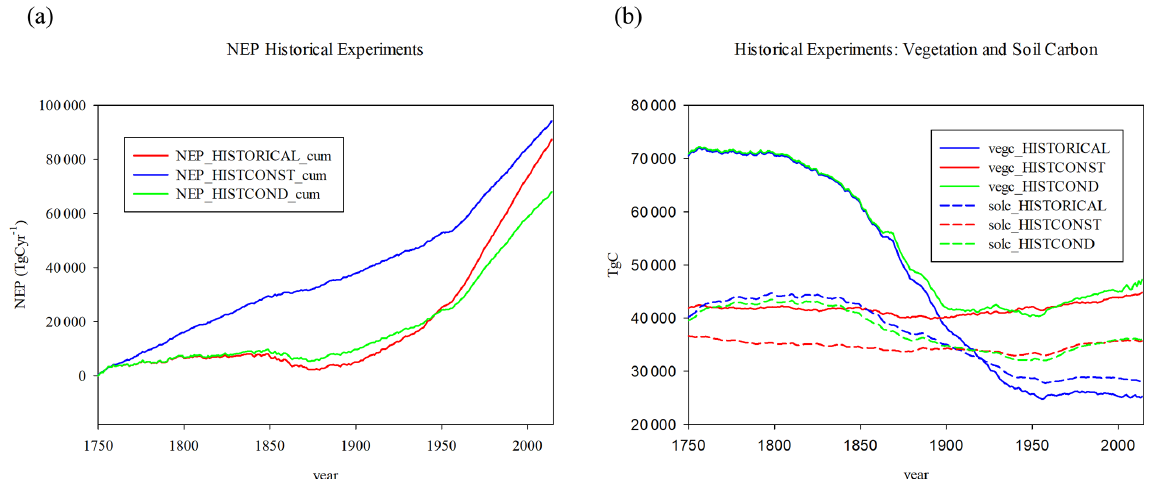
Figure 2. Historical experiments (a) cumulative NEP (TgCyr − 1 ), (b) vegetation carbon (vegc), and soil carbon (solc) in TgC. Experiments are HISTORICAL, HISTCONST, and HISTCOND (see text).